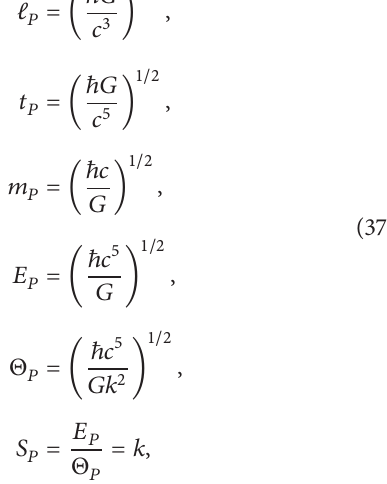
The current consensus appears to be 27% matter and 73% dark energy. However, we propose 18% and 82%,